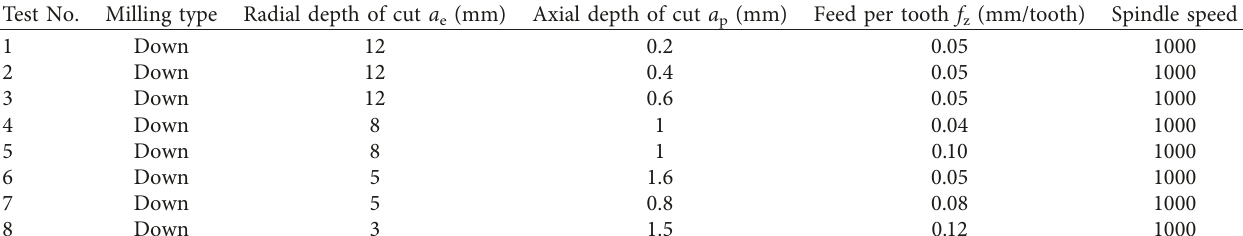
Table 4: Cutting conditions for a cutter entering from the workpiece